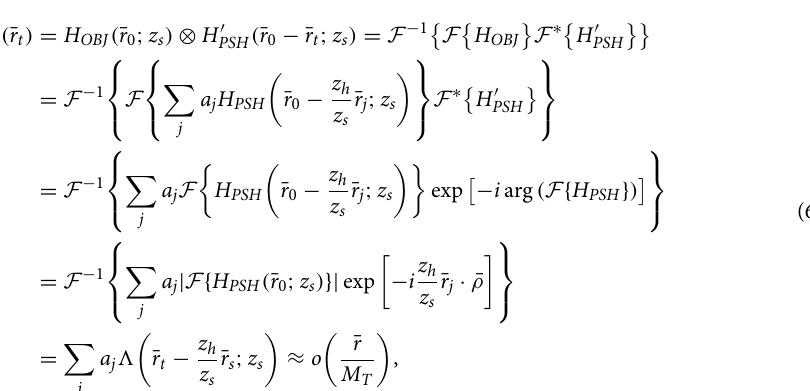
Figure 10. Schematic of modified GSA used for synthesizing the